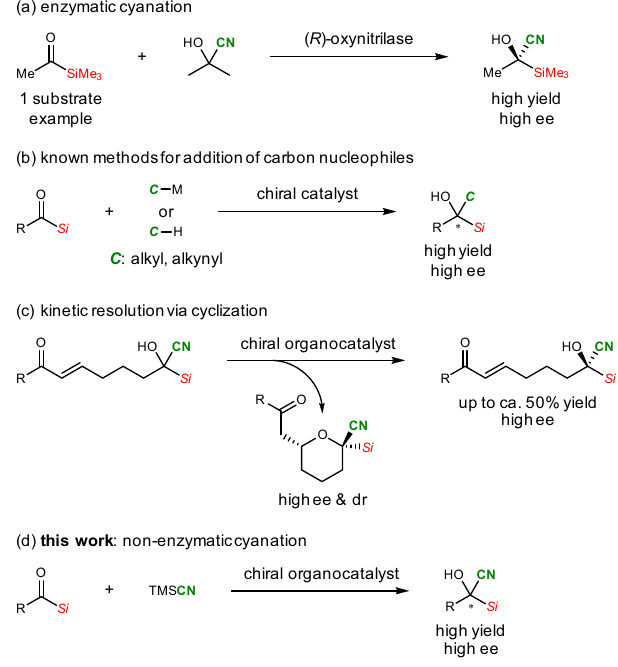
Fig. 1 Catalytic asymmetric nucleophilic addition to acylsilanes. a Enzymatic cyanation 33,34 . b Known methods for the addition of carbon nucleophiles 46 – 51 . c Kinetic resolution via cyclization 59 . d Non-enzymatic